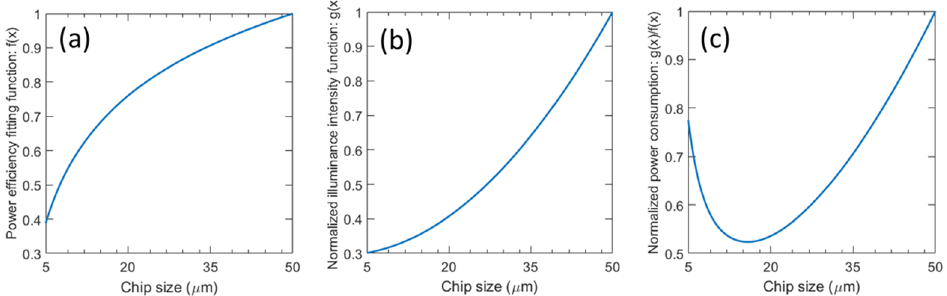
Figure 11. Normalized ( a ) power efficiency fitting function f(x), ( b ) luminance intensity function g(x), and ( c ) power consumption function g(x)/f(x) at different LED chip sizes.